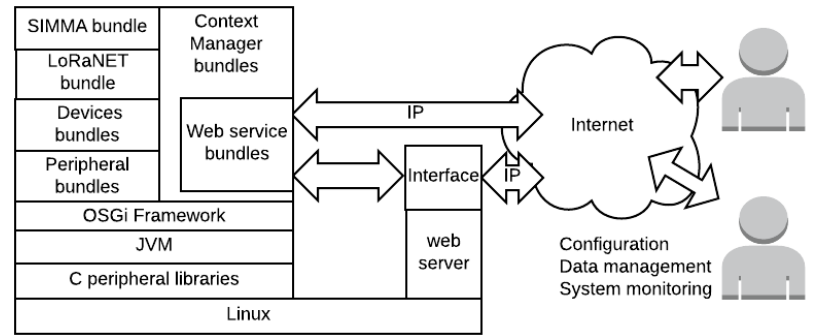
Figure 7. Control node software architecture.